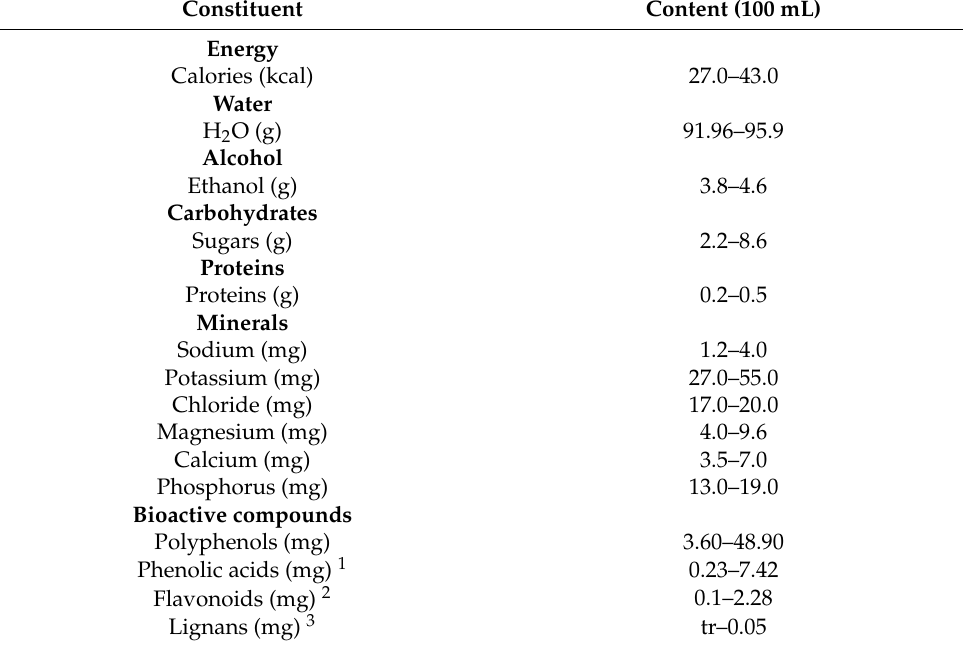
Table 1. Constituents of a regular